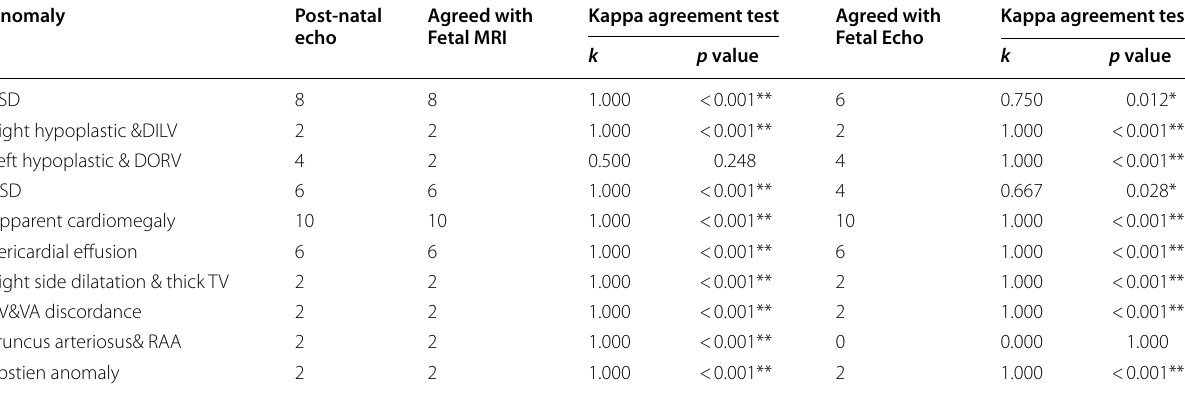
Table 4 Comparison between agreement of Fetal MRI and Fetal Echo with Post-natal echo regarding individual congenital anomaly (n 34) =